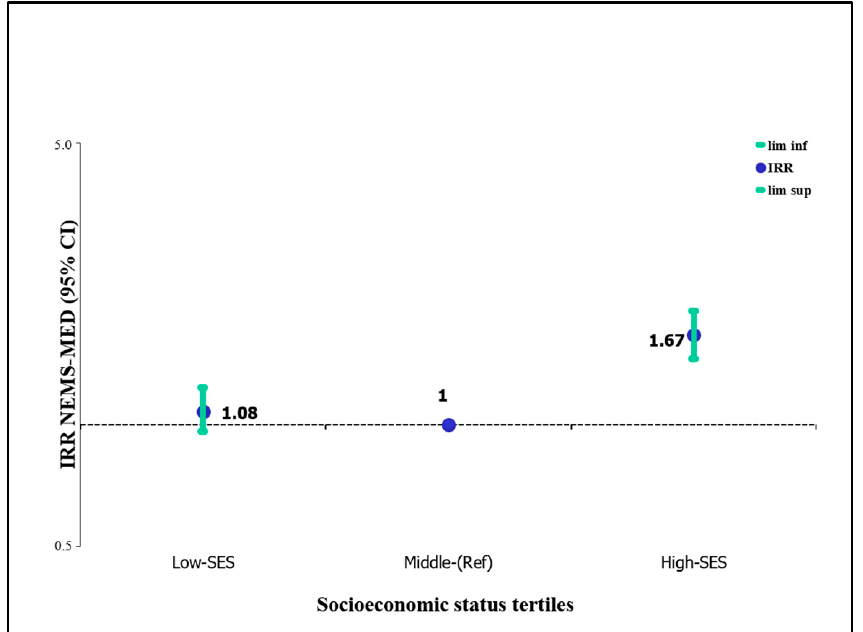
Figure 2. Association between the Healthy Food Availability Index (HFAI) of each food establishment and the socio-economic status of schools at the neighborhood level using Poisson regression. Model adjusted for population density and distance.